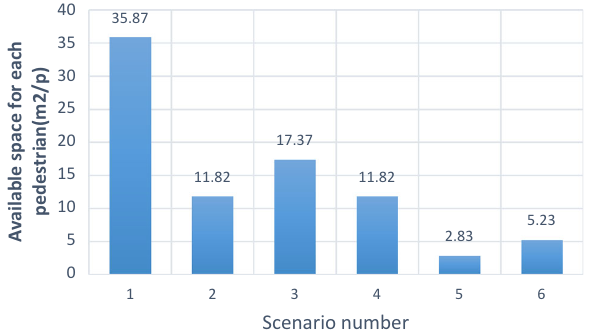
Fig. 5 Pedestrian space in ticket control section under different scenarios